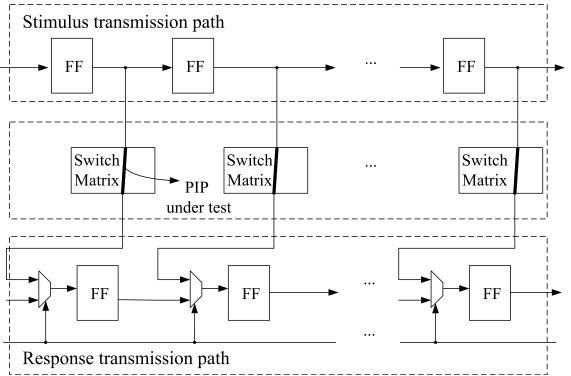
Figure 10. Test structure of the oblique